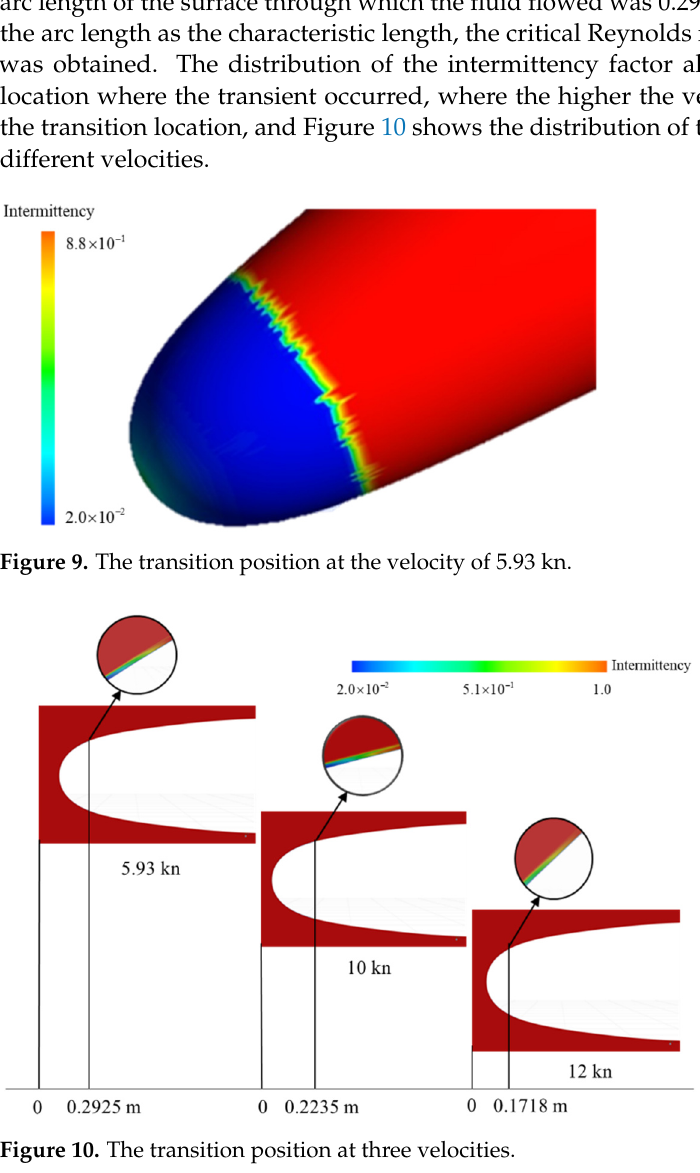
Figure 10. The transition position at three velocities. Table 3. The parameters of the transition point at different velocities.